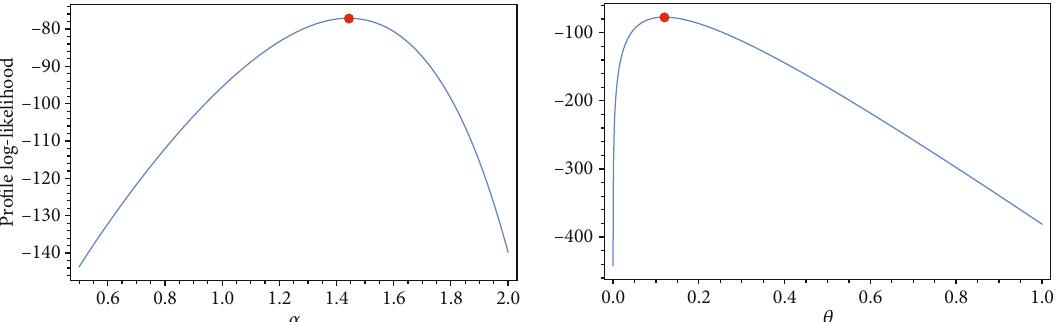
Figure 5: Plots of log-likelihood function for each estimated parameters.